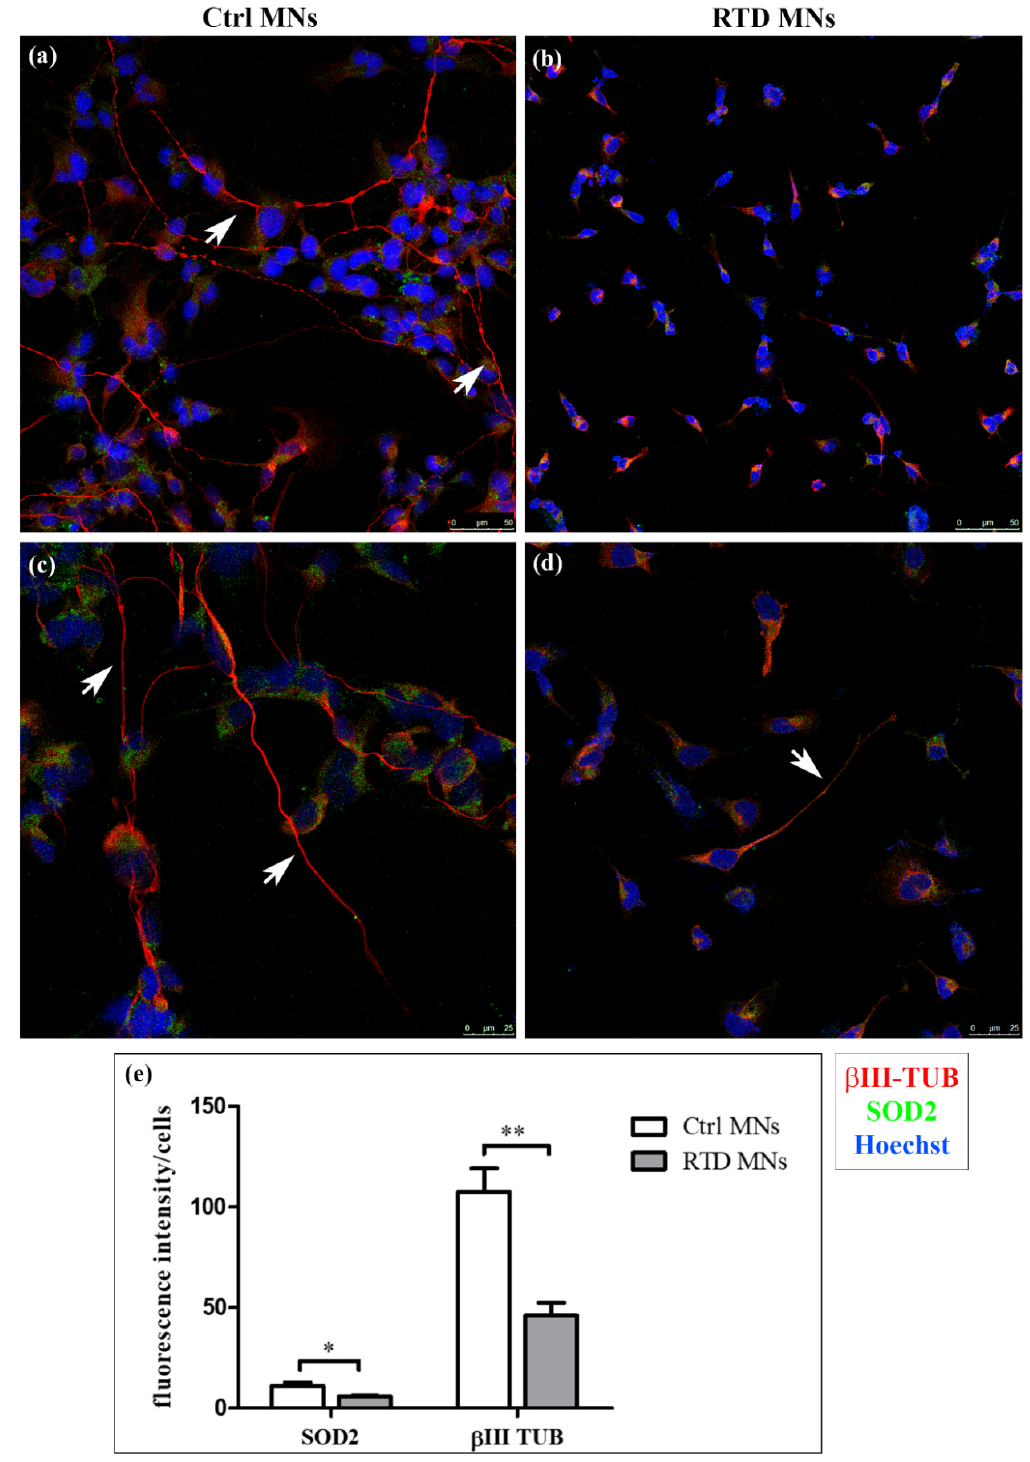
Figure 1. Confocal analysis of riboflavin transporter deficiency (RTD) vs. Ctrl motor neurons (MNs). ( a – d ) Immunofluorescence images showing the distribution of β III-Tubulin ( β III-TUB) (red) and superoxide dismutase 2 (SOD2) (green). Nuclei are stained with Hoechst (blue). White arrows indicate neurites in ( a , c – e ) Significantly lower levels of β III-TUB and of the mitochondrial marker SOD2 are detected in diseased MNs (* p ≤ 0.05 vs. Ctrl MNs; ** p ≤ 0.01 vs. Ctrl MNs). White columns indicate Ctrl cells, while grey ones indicate diseased MNs.